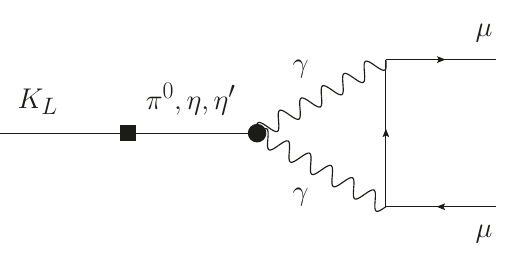
Figure 1 . Leading order Feynman diagram of the long-distance two-photon contribution to K L → µ + µ −